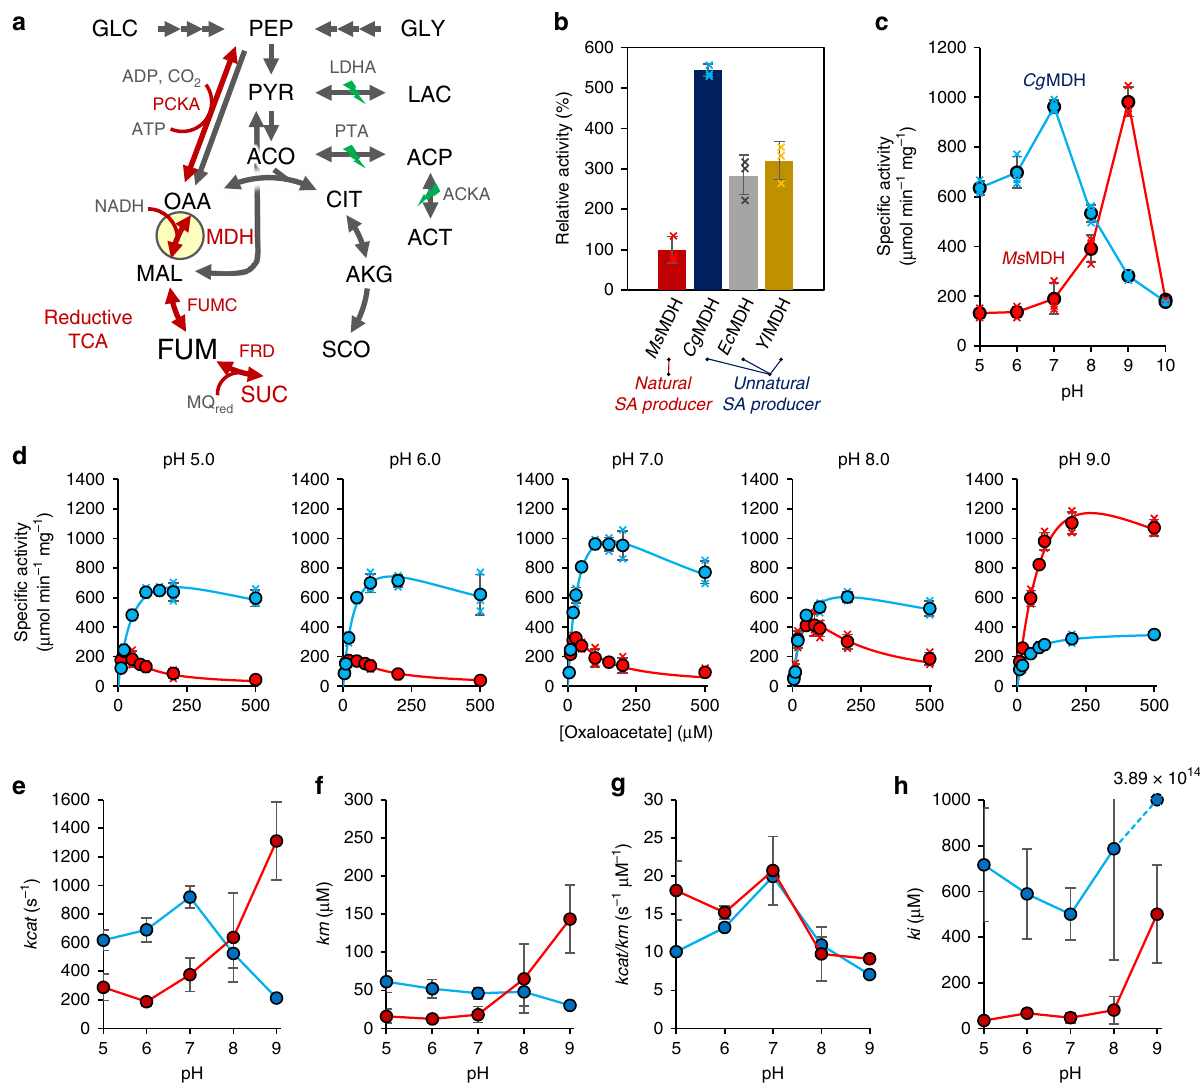
Fig. 1 Comparison of MDH activities. a SA biosynthetic pathway in the M. succiniciproducens PALK strain. Deleted genes are indicated as green thunder symbol. Key enzymes in SA production are indicated as red arrows. GLC glucose, PEP phosphoenolpyruvate, GOL glycerol, PYR pyruvate, LAC lactate, ACO acetyl-CoA, ACP acetyl-phosphate, ACT acetate, OAA oxaloacetate, MAL malate, FUM fumarate, SUC succinate, SCO succinyl-CoA, AKG alpha- ketoglutarate, CIT citrate, PCKA phosphoenolpyruvate carboxylase, LDHA lactate dehydrogenase, PTA phosphate acetyltransferase, ACKA acetate kinase, MDH malate dehydrogenase, FUMC fumarate hydratase, FRD fumarate reductase, MQ red menaquinol. b The relative activities of four MDHs from various SA producers, including M. succiniciproducens , C. glutamicum , E. coli , and Y. lipolytica , in comparison with the activity of Ms MDH ( n = 3